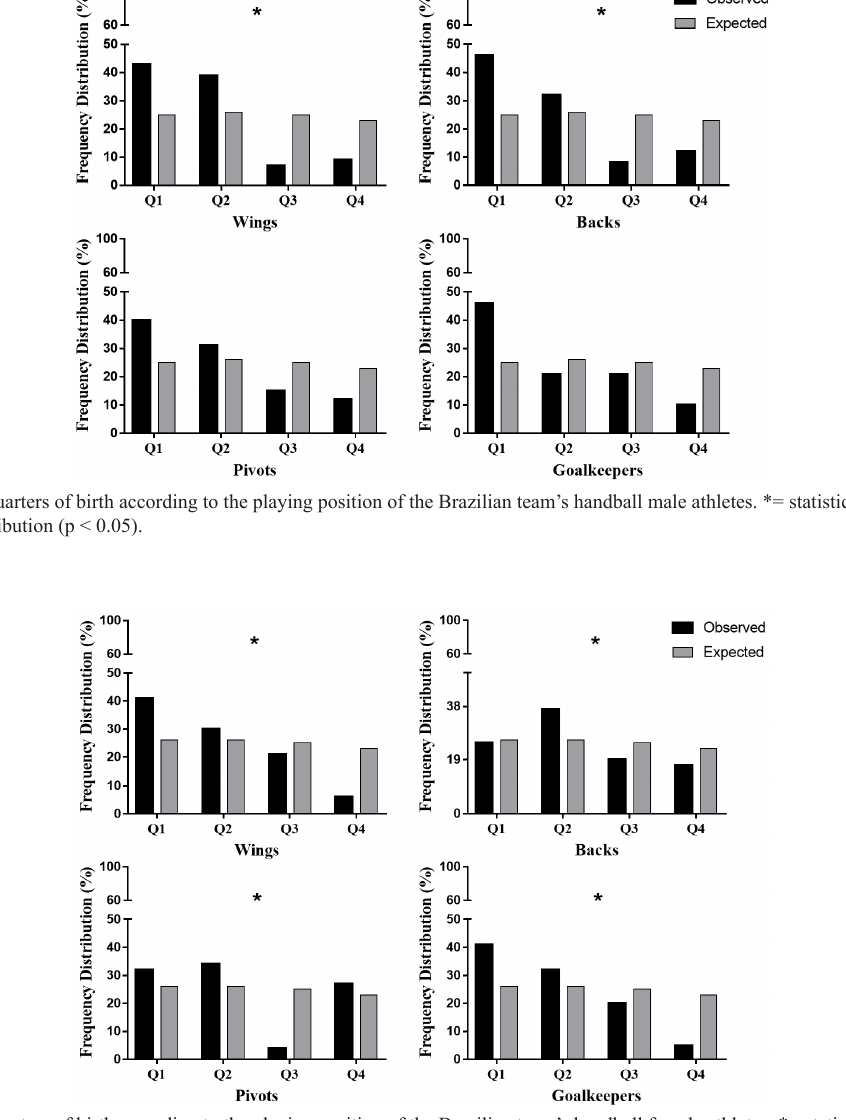
Figure 2 - Distribution of quarters of birth according to the playing position of the Brazilian team’s handball female athletes. *= statistical difference between the observed and expected distribution (p <